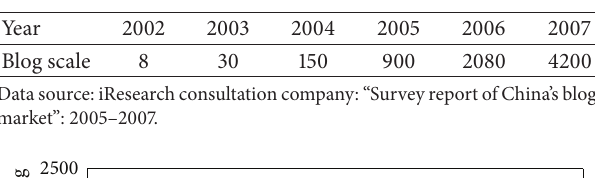
Table 1: China’s blog scale in the past year (ten thousand persons).